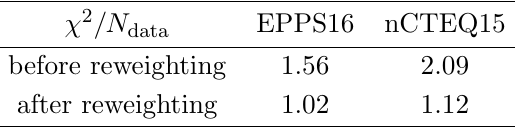
Table 1 . Values of (cid:31) 2 =N data for the EPPS16 and nCTEQ15 nPDFs before and after reweighting. mate the impact of the LHCb data for R D 0 on the EPPS16 and nCTEQ15 nPDFs pPb